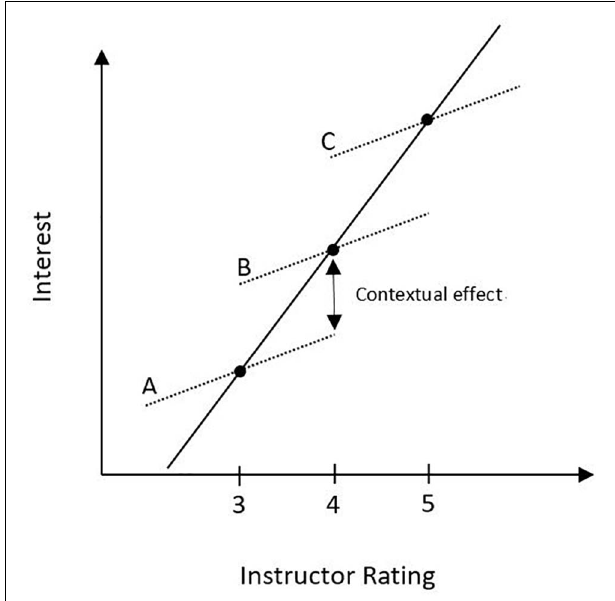
FIGURE 2 | An illustration of a compositional effect associated with being a student in classroom B as opposed to a student in classroom A. In this case, the direction of the student-level effect and the class-level effect are in the same